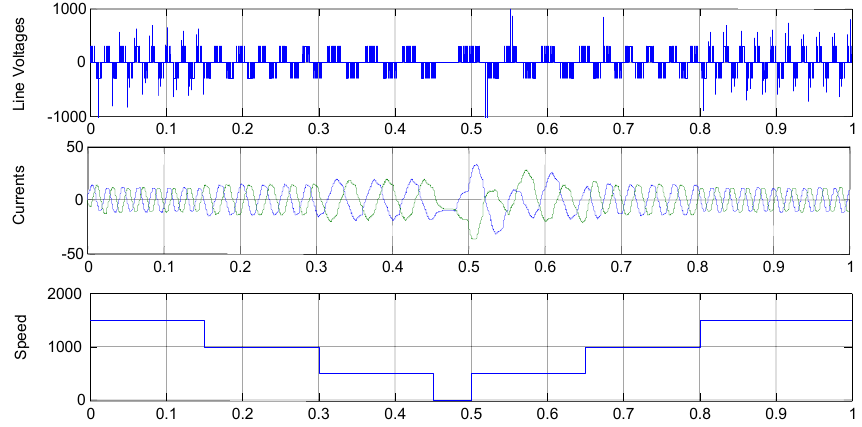
Figure 7. Effect of speed variation (increment/decrement) on voltage and current using the main battery.